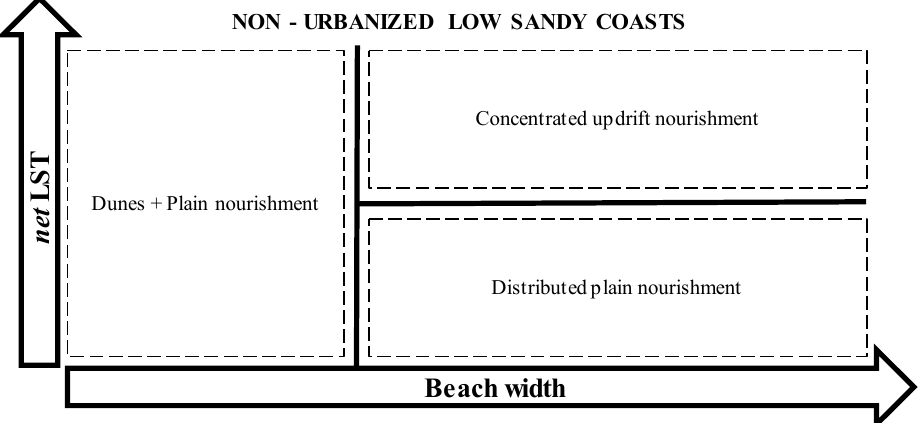
Figure 4. Guidelines for erosion mitigation strategies ( div (LST) = divergence of long-shore sediment transport) for non-urbanized low sandy coasts.